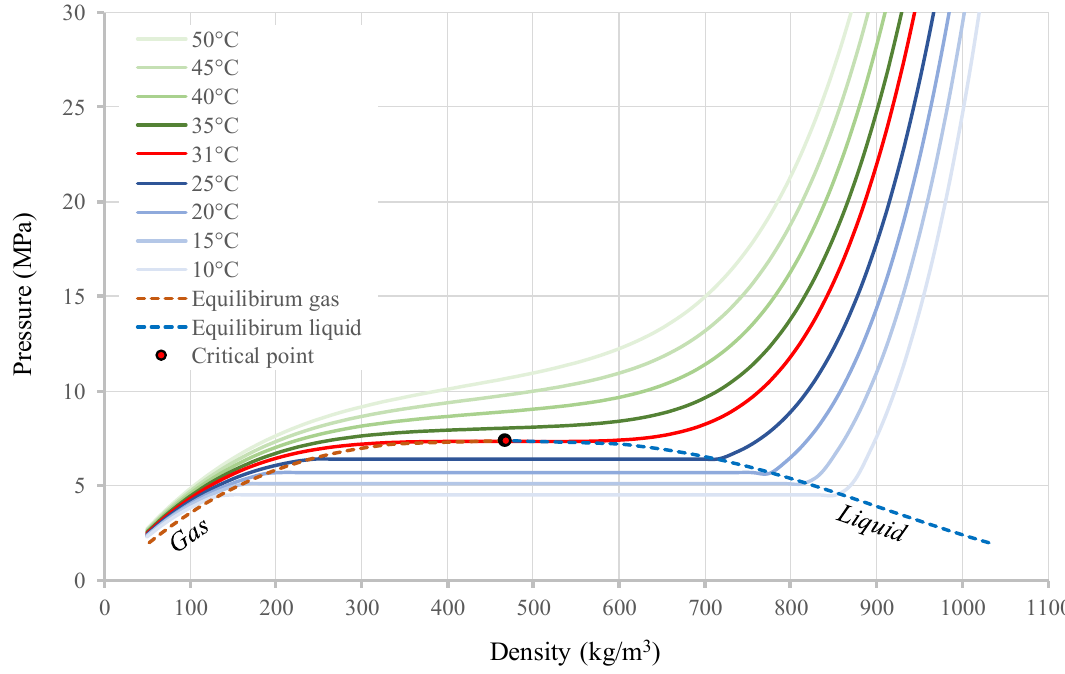
Figure 2. Selected pressure vs. density isotherms for carbon dioxide calculated with a published equation of state [25].